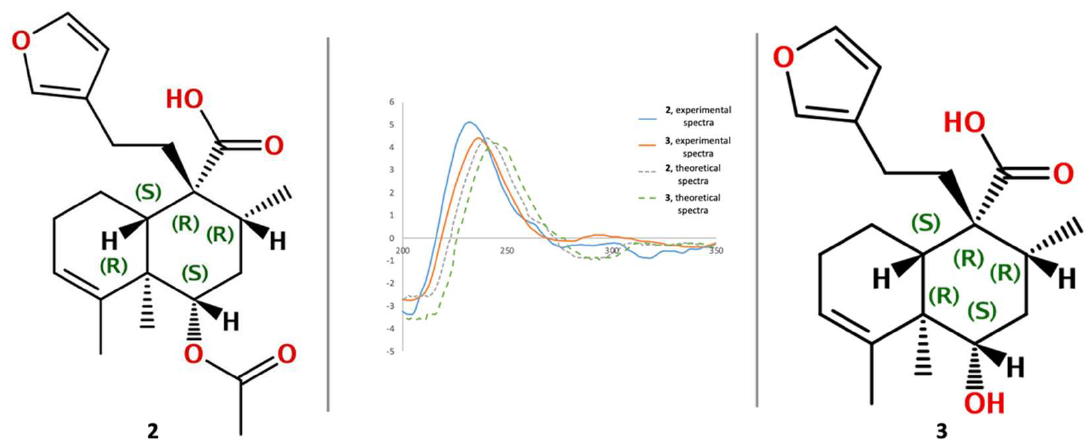
Figure 4. Experimental circular dichroism (CD) spectra for compounds 2 and 3 , in addition to the calculated CD spectra. calculated CD